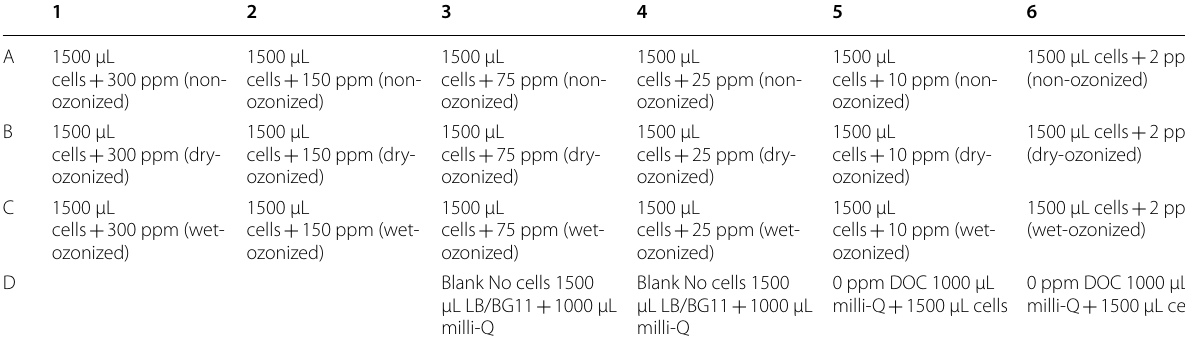
The first three rows show the DOC concentrations (ppm) of the biochar filtrates from low to high concentration (right to left). The filtrates from the non-ozonized biochar, dry-ozonized biochar, and wet-ozonized are represented in row A, B, and C, respectively. The wells labeled “0 ppm DOC” are the controls with no DOC, and the wells labeled “Blank” contain the growth medium without